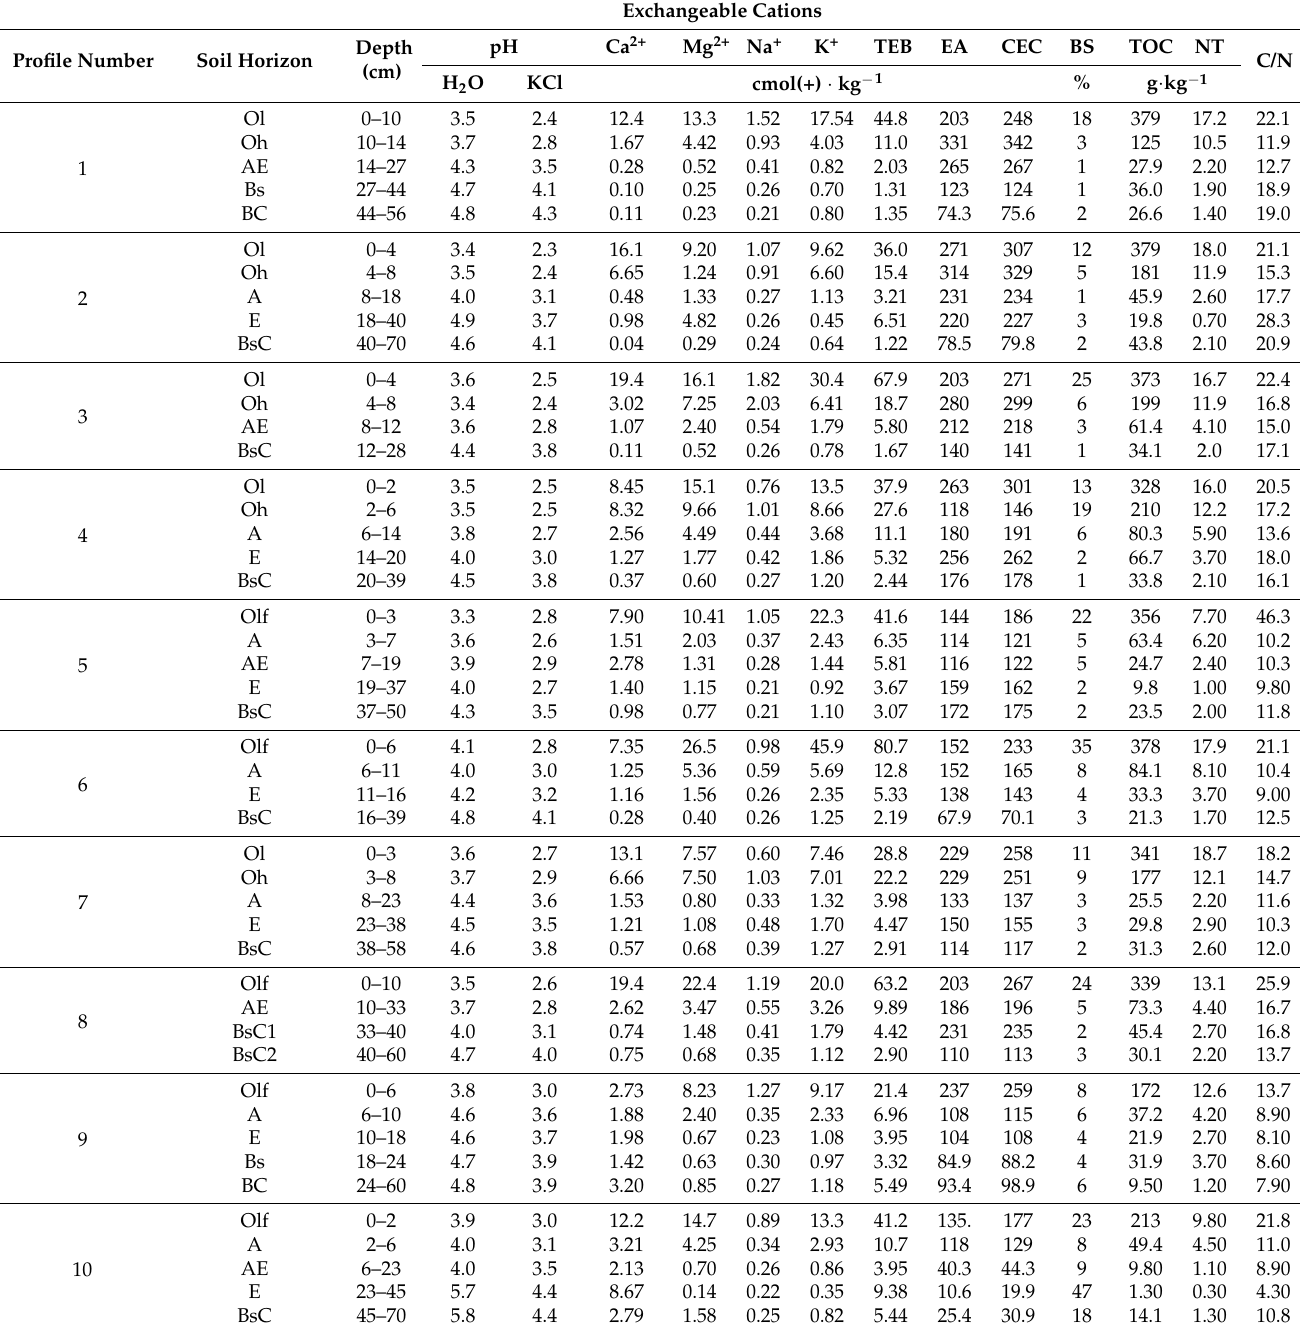
Table 2. Selected chemical